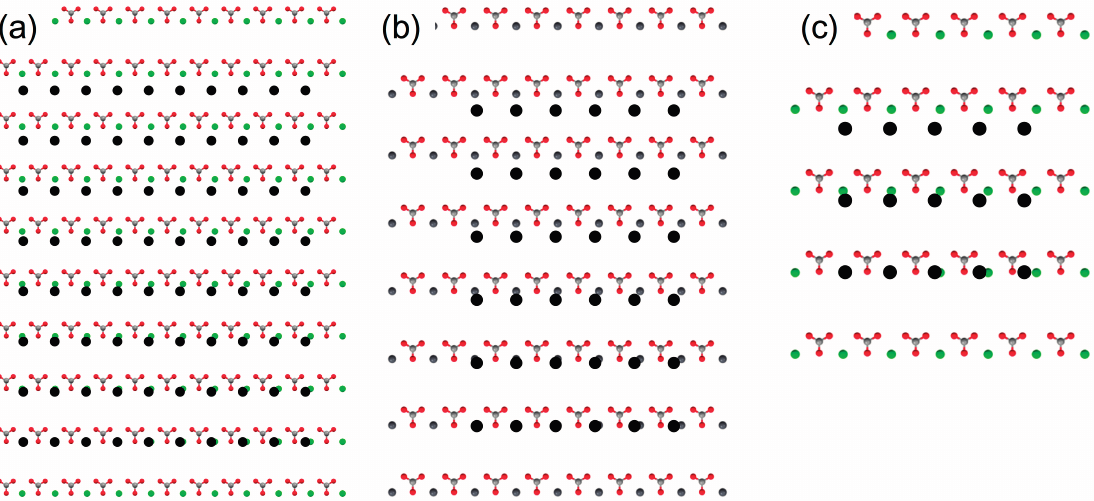
Figure 2. Molecular models to show the maximum supercell dimensions of aragonite (0 0 1) that generated the dimensionless potential ( V / V o ) less than 0.5 with the (0 0 1) planes of the substrates: ( a ) SrCO 3 ; ( b ) PbCO 3 ; and ( c ) BaCO 3 . The filled black circles are the lattice points of aragonite